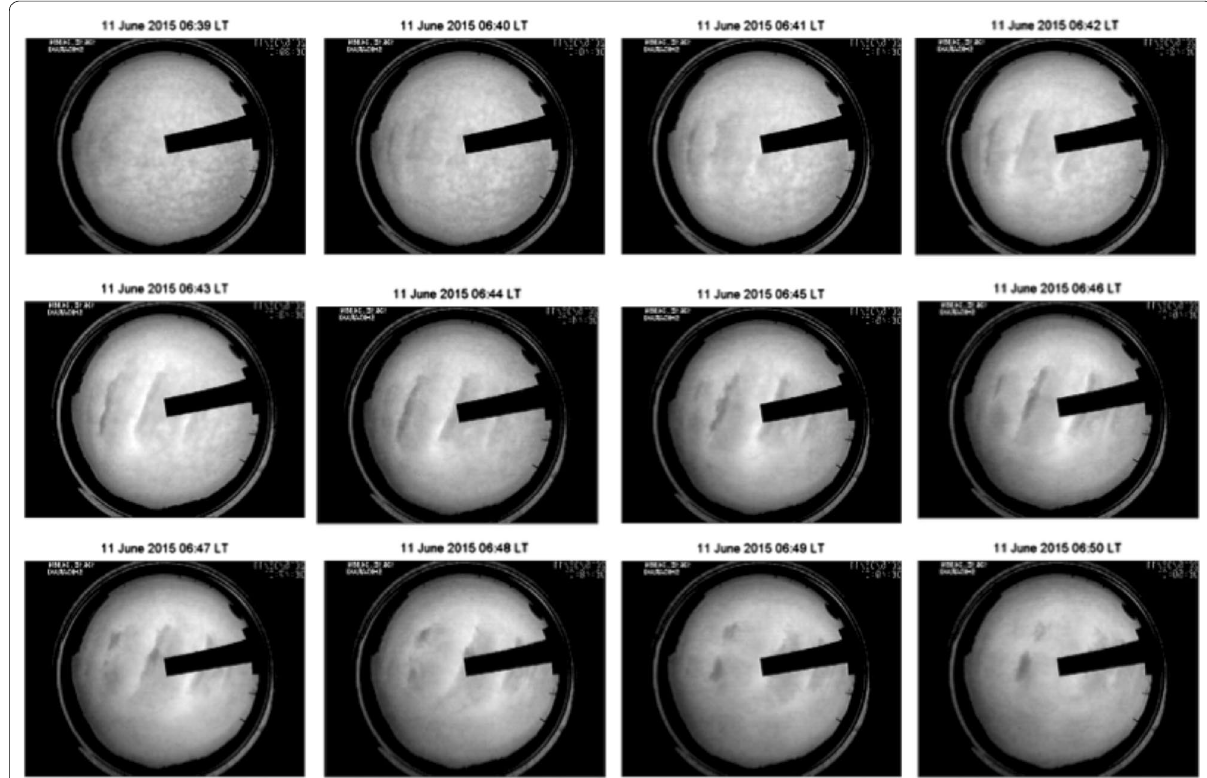
Fig. 10 Photographs of the cloud base taken by the fish-eye camera every minute between 0639 and 0650 LT